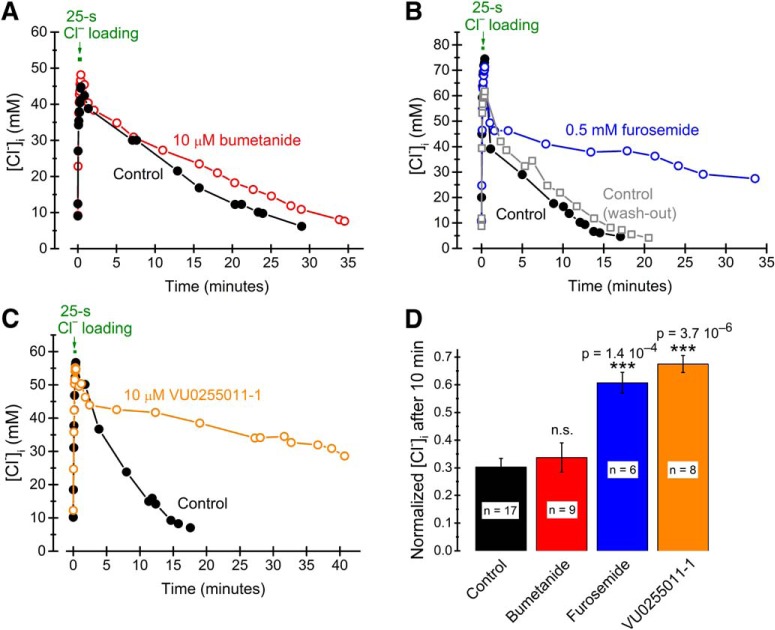
Pharmacology of transporter-mediated recovery of [Cl–]i. A–C, [Cl–]i recovery under control conditions (black filled circles) and in the presence of 10 µM bumetanide (A, red open circles), 0.5 mM furosemide (B, blue open circles), and 10 µM VU0255011-1 (C, orange open circles), with control and drug application for the same cell. Cl– was loaded and [Cl–]i quantified as in Figure 2. D, Summary of drug effects on the level of [Cl–]i after 10 min recovery, measured as [Cl–]i normalized to maximal [Cl–]i during Cl– loading. Note the lack of significant effect of the NKCC1-blocker bumetanide but highly significant effects of the KCC2 blockers furosemide and VU0255011-1.